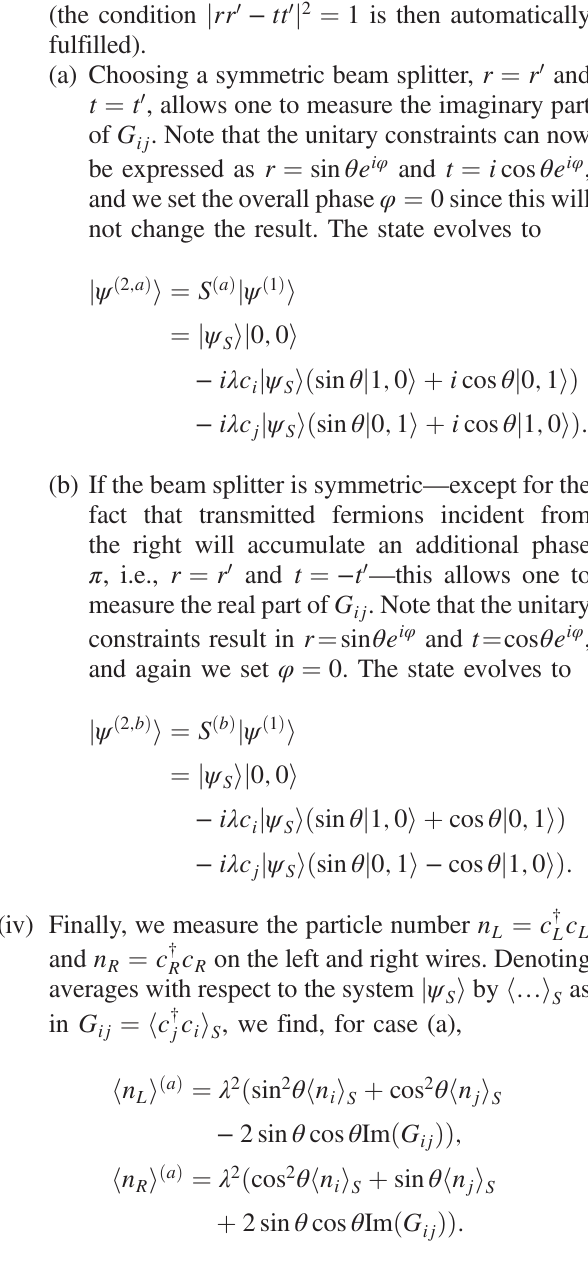
and n are measured on each side. In the first L R . In the second measurement ij ij